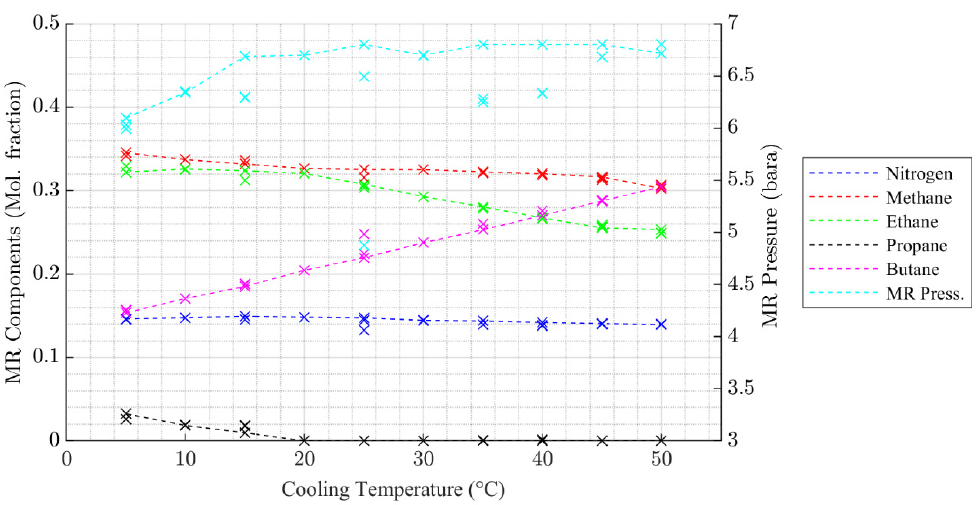
Figure 4. Variation in OP for the MR pre-cooling step with cooling temperature.